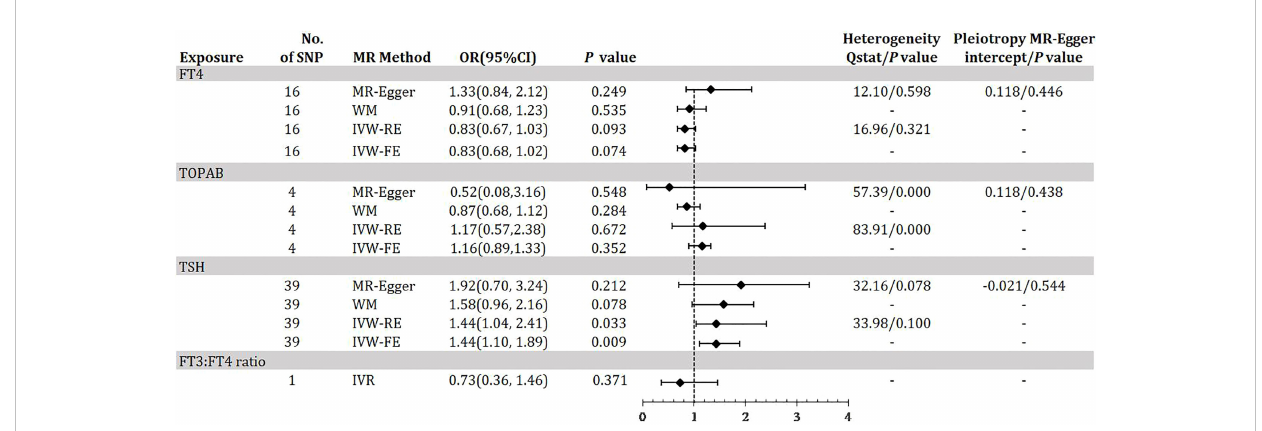
FIGURE 2 Odds ratio for association of genetically predicted thyroid function with DKD. FT4, free thyroxine; FT4, free thyroxine; FT3, free triiodothyronine; TSH, thyroid-stimulating hormone; TPOAB, thyroid peroxidase antibodies; DKD, diabetic kidney disease; CI, con fi dence internal; OR, odds ratio; IVW-FE, inverse-variance weighted fi xed-effects MR; IVW-RE, inverse-variance weighted random-effects MR; MR, mendelian randomization; WM, weighted median; IVR, instrumental variable ratio (Wald) estimator; SNP, single-nucleotide polymorphism. P value for heterogeneity based on Cochran ’ s Q statistic for IVW, and Rücker ’ s Q for